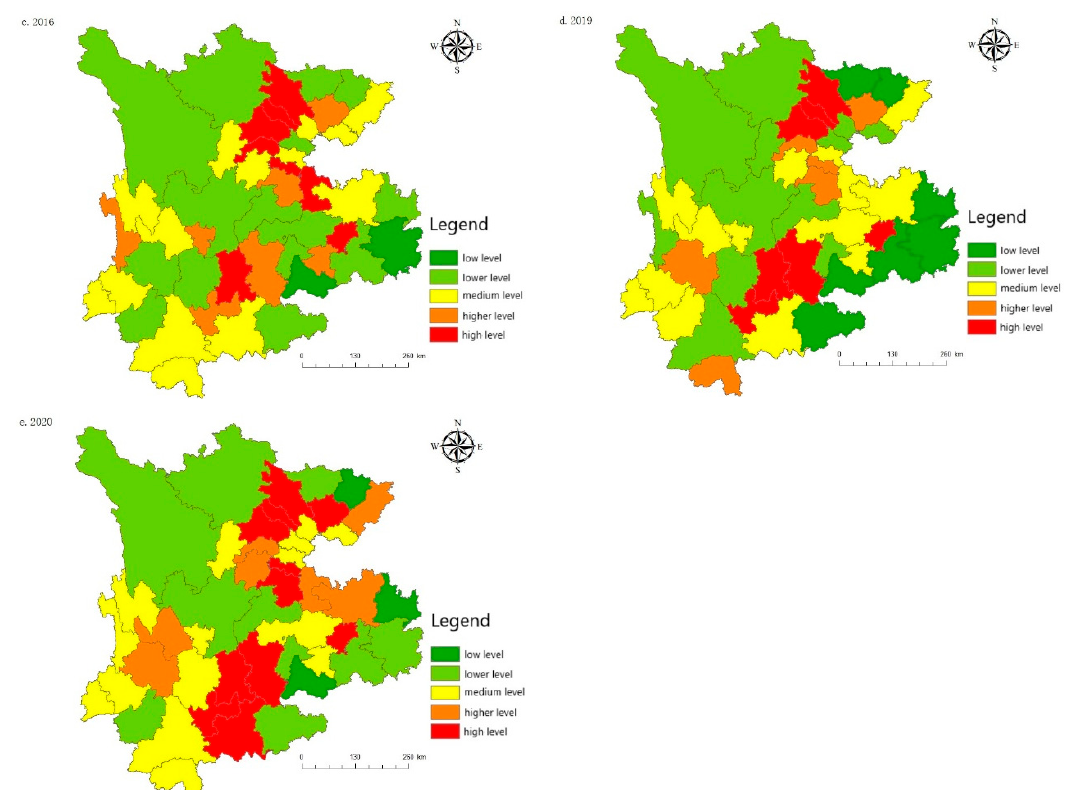
Figure 8. Spatial distribution of the technology development level : ( a ) The technology development level in 2010; ( b ) The technology development level in 2013; ( c ) The technology development level in 2016; ( d ) The technology development level in 2019; ( e ) The technology development level in 2020.